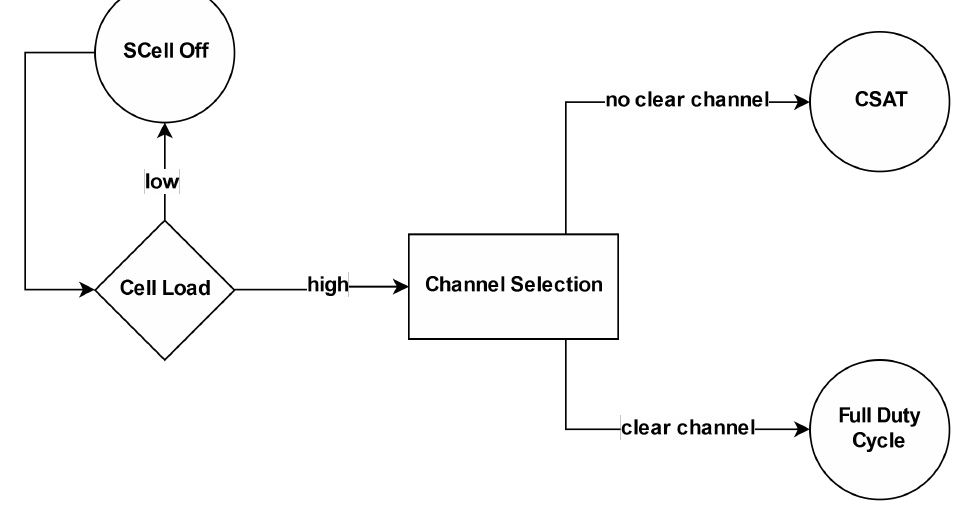
Figure 1. Coexistence flowchart of long-term evolution-unlicensed (LTE-U) adapted from